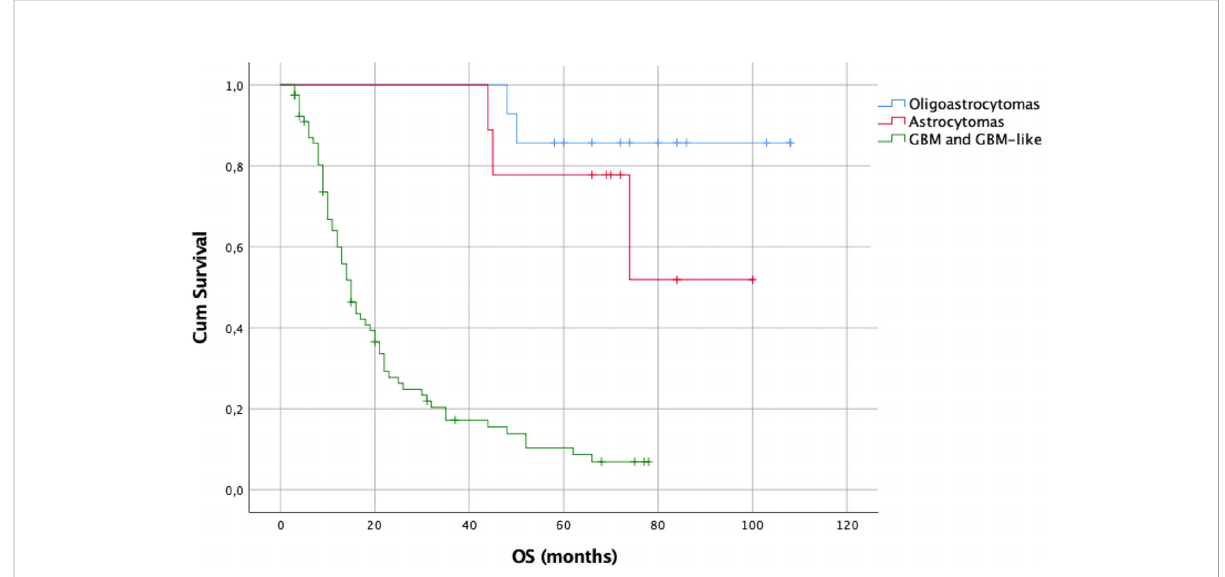
FIGURE 10 Kaplan – Meier curves of OS according to glioma molecular subtypes at fi rst